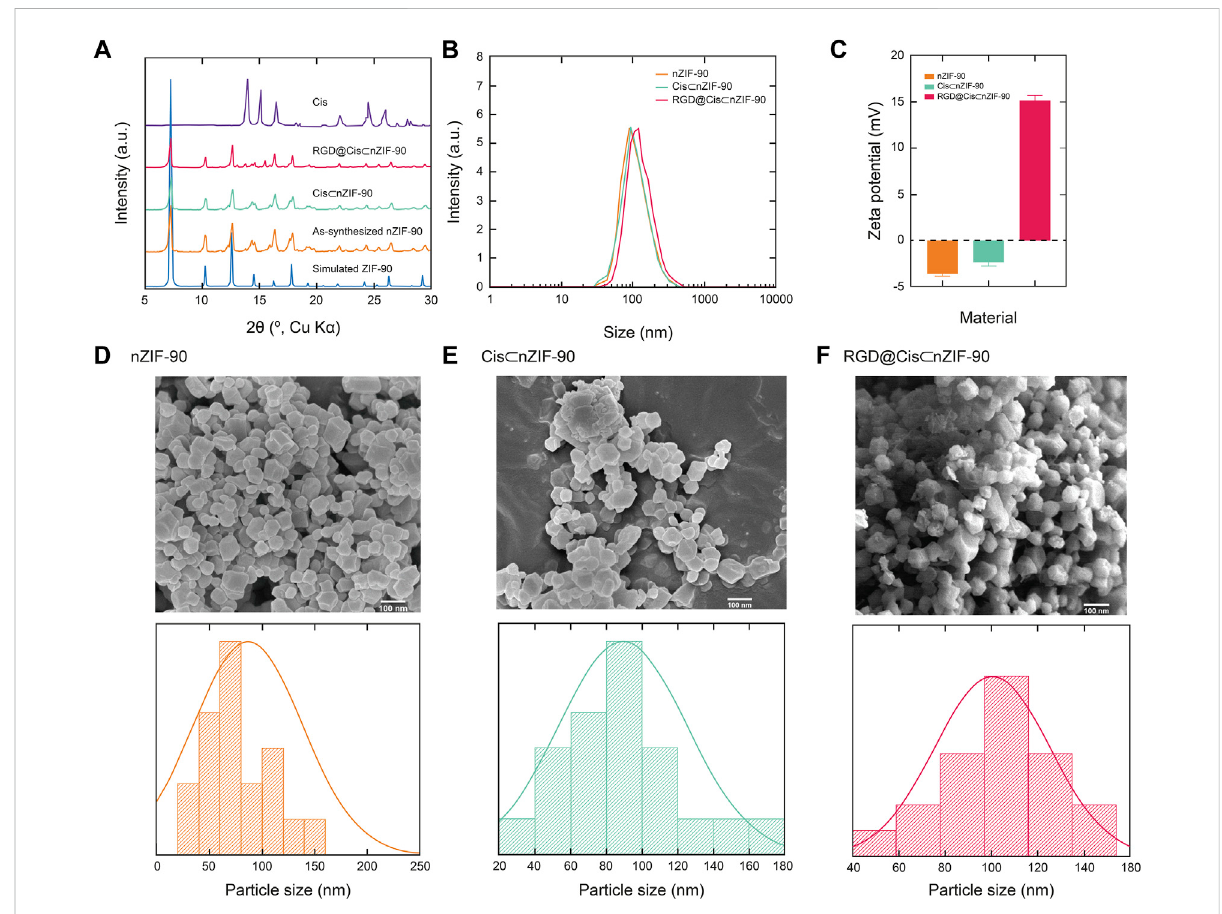
FIGURE 1 (A) Powder X-ray diffraction (PXRD) patterns for the simulated nZIF-90 crystal structure (blue), as-synthesized nZIF-90 (orange), Cis ⊂ nZIF-90 (green),RGD@Cis ⊂ nZIF-90(red)andCis(purple). (B) DynamiclightscatteringparticlesizedistributionofnZIF-90,Cis ⊂ nZIF-90,andRGD@Cis ⊂ nZIF- 90. (C) Zeta-potential of nZIF-90, Cis ⊂ nZIF-90, and RGD@Cis ⊂ nZIF-90. Field-emission scanning electron microscopy (FE-SEM) images with the corresponding size distribution histograms of (D) nZIF-90 (E) Cis ⊂ nZIF-90, (F) RGD@Cis ⊂